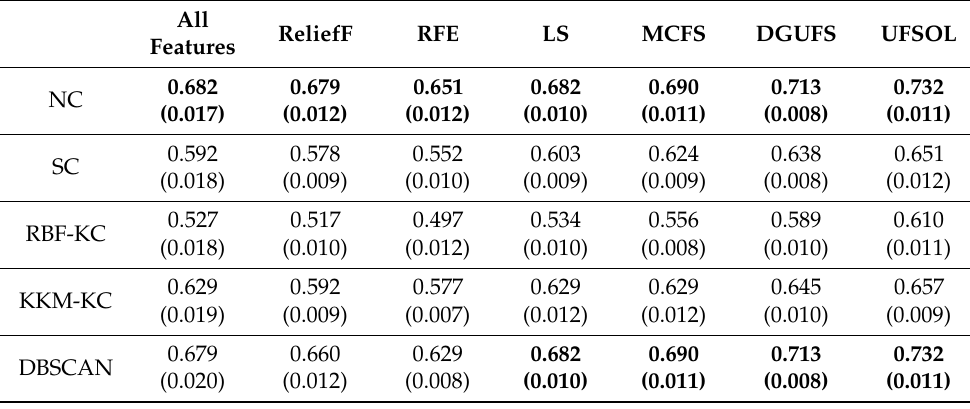
Table 6. Recall of clustering algorithms with different feature selection methods.